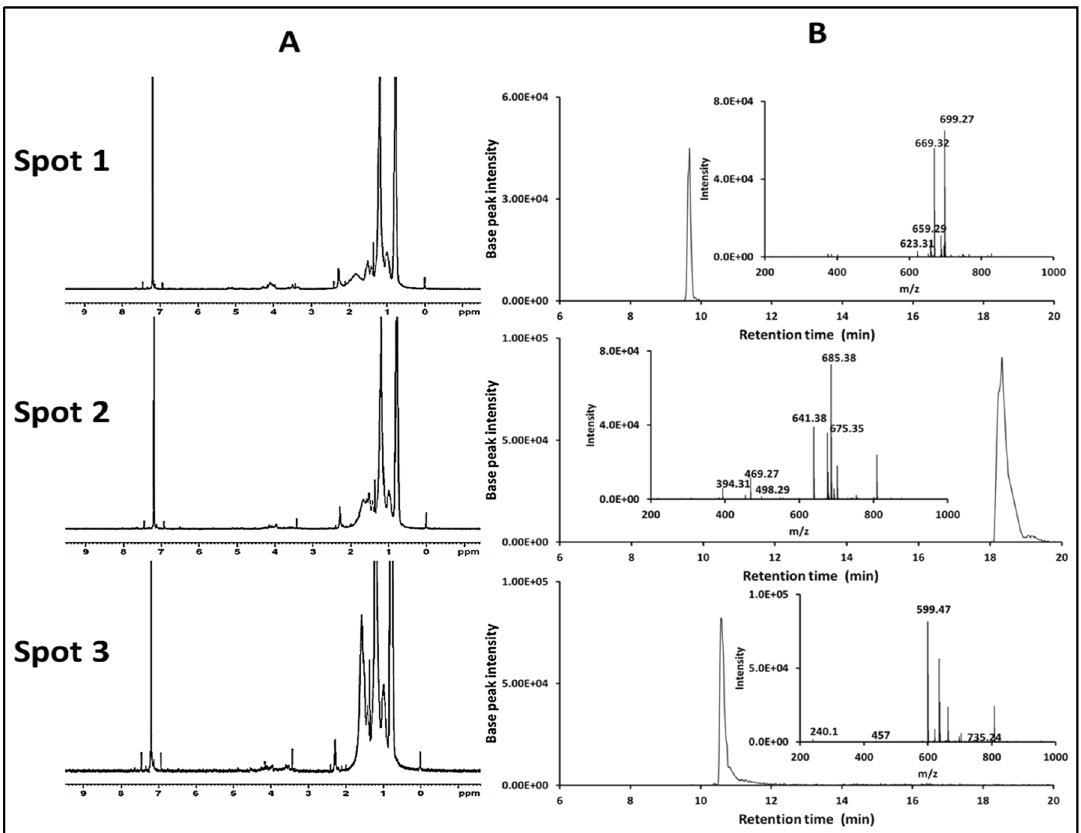
Figure 4. 1 H NMR spectra ( A ) and corresponding HPLC-QTOF-HRMS analysis ( B ) of the 3 Kocuria sp. RAM1 purified pigments (spot 1 = bisanhydrobacterioruberin, spot 2 = trisanhydrobacterioruberin and spot 3 = 3,4,3 ʹ ,4 ʹ -tetrahydrospirilloxanthin).